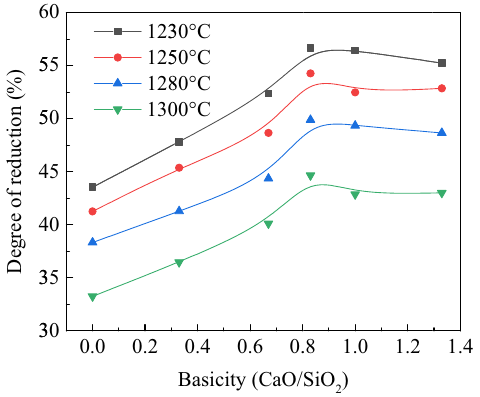
Figure 9: Morphology of reduced briquettes with di ff erent basicity values fi red at 1,280°C and reduction for 60 min.